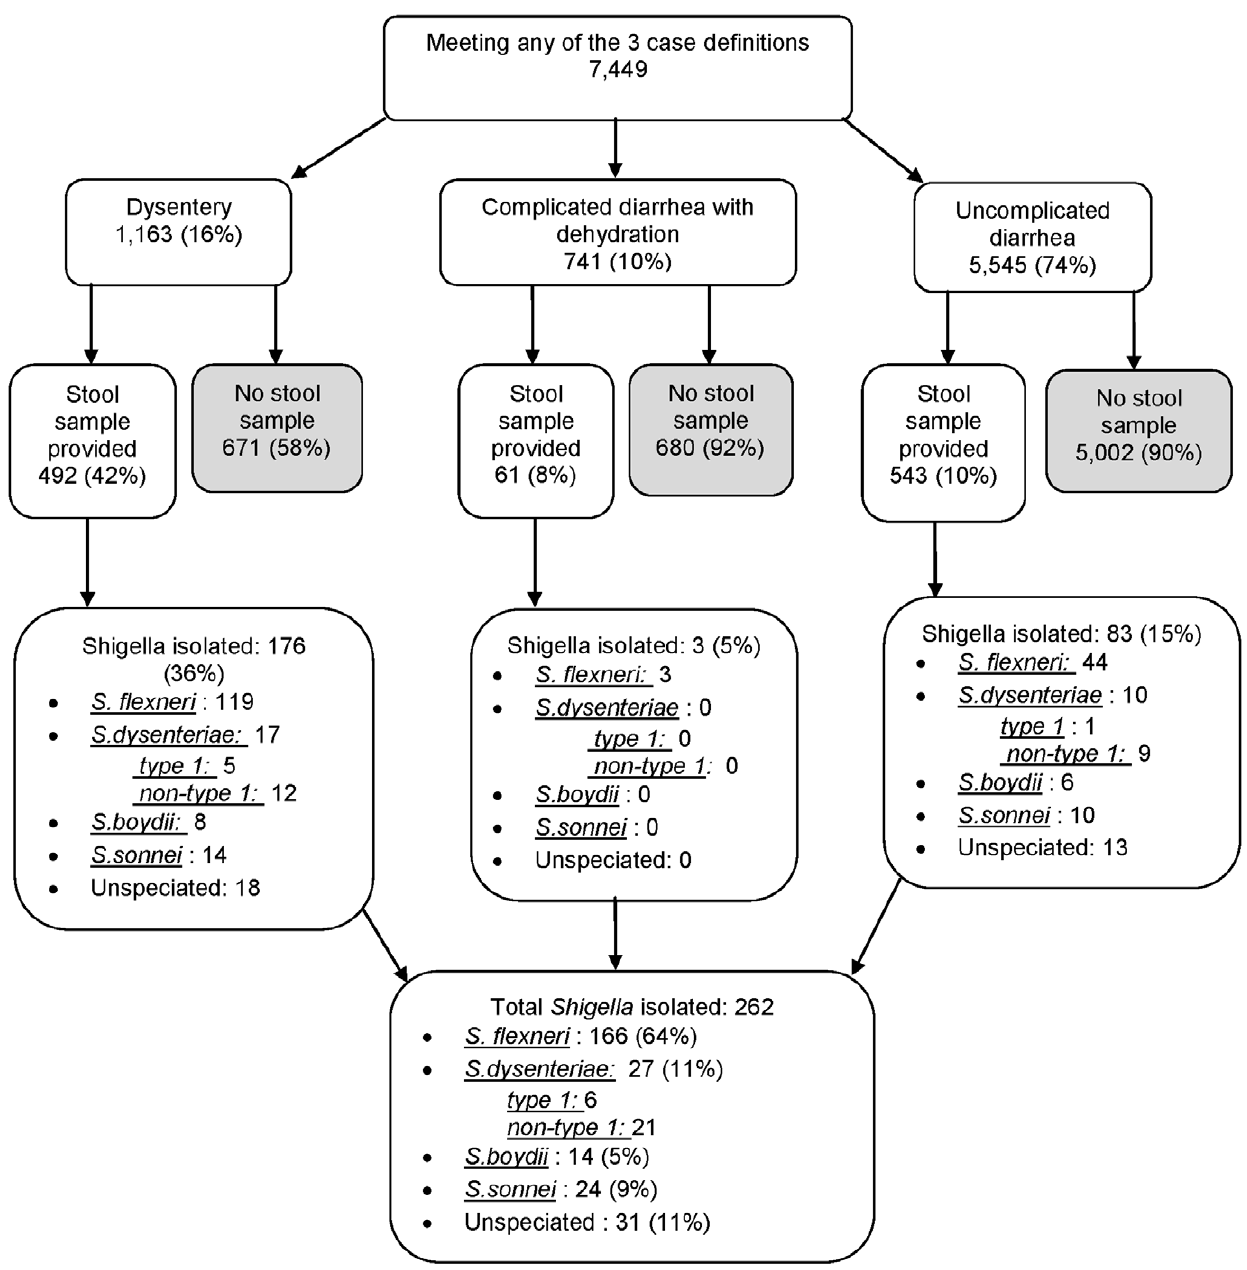
Figure 2. Flow chart illustrating distribution of diarrhea cases and shigella species isolated between 1 Jan 2007 and 31 Dec 2010 in Kibera, Kenya.